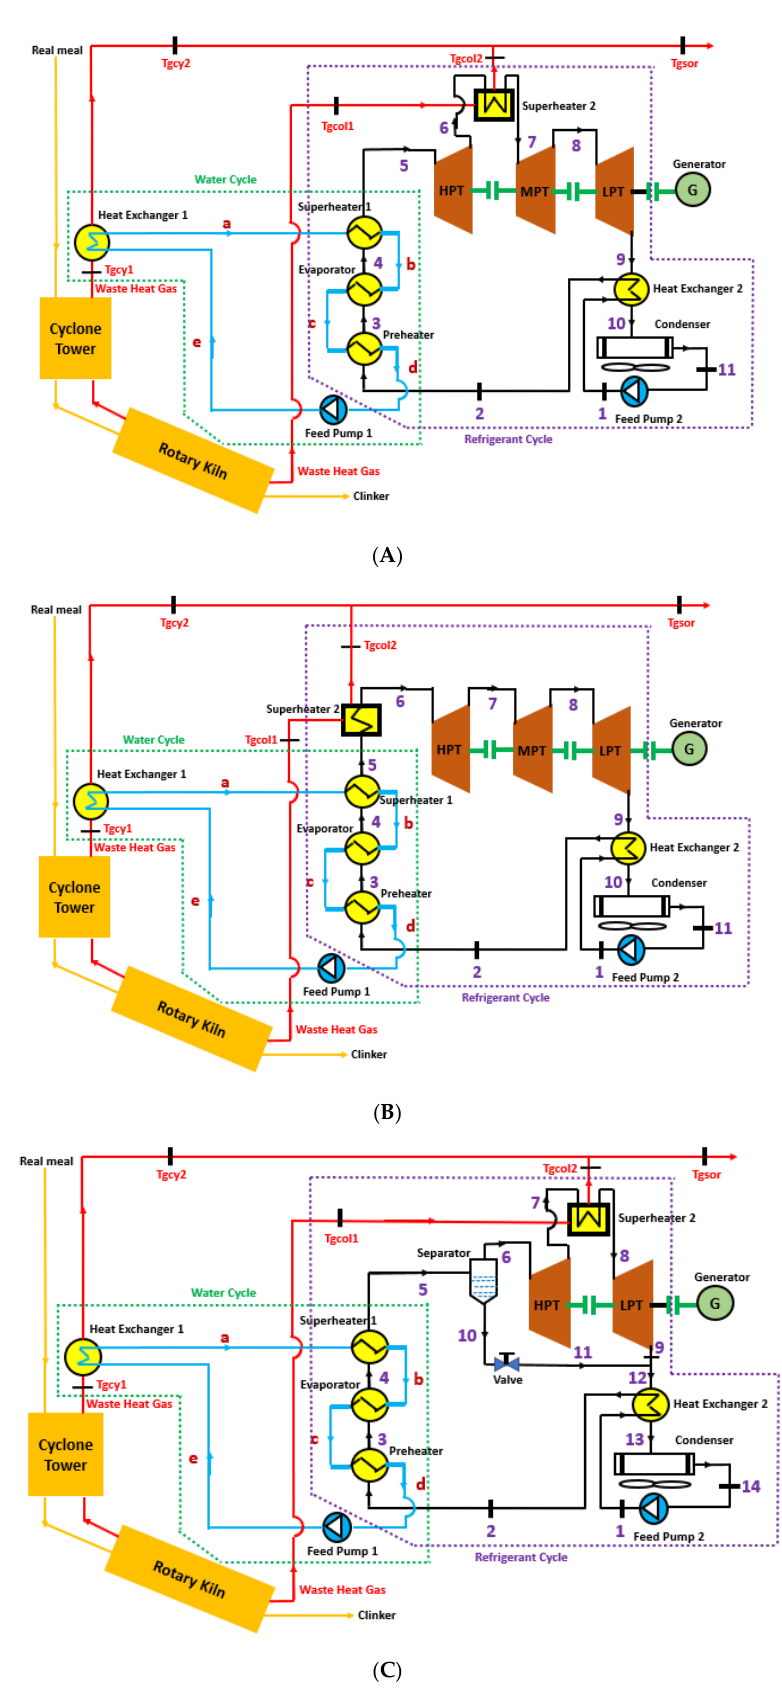
Figure 2. Diagram of Kalina Cycles: ( A ) KCA system, ( B ) KCB system, and ( C ) KCC